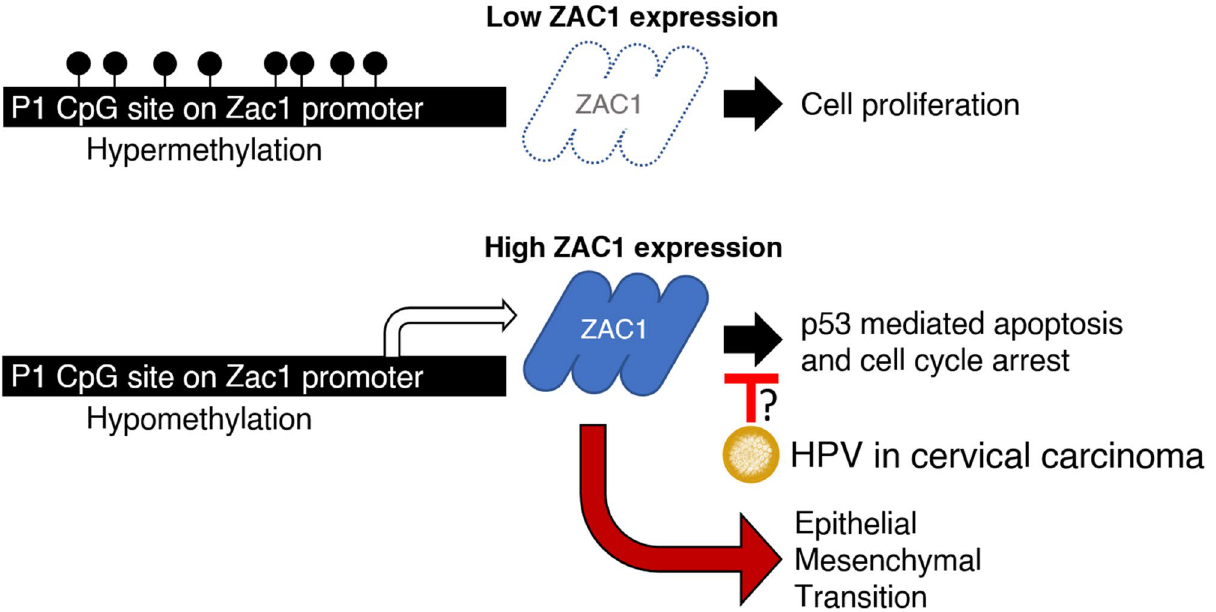
Figure 9. Diagrammatic representation illustrate the postulated tumorigenic role of ZAC1 in cervical